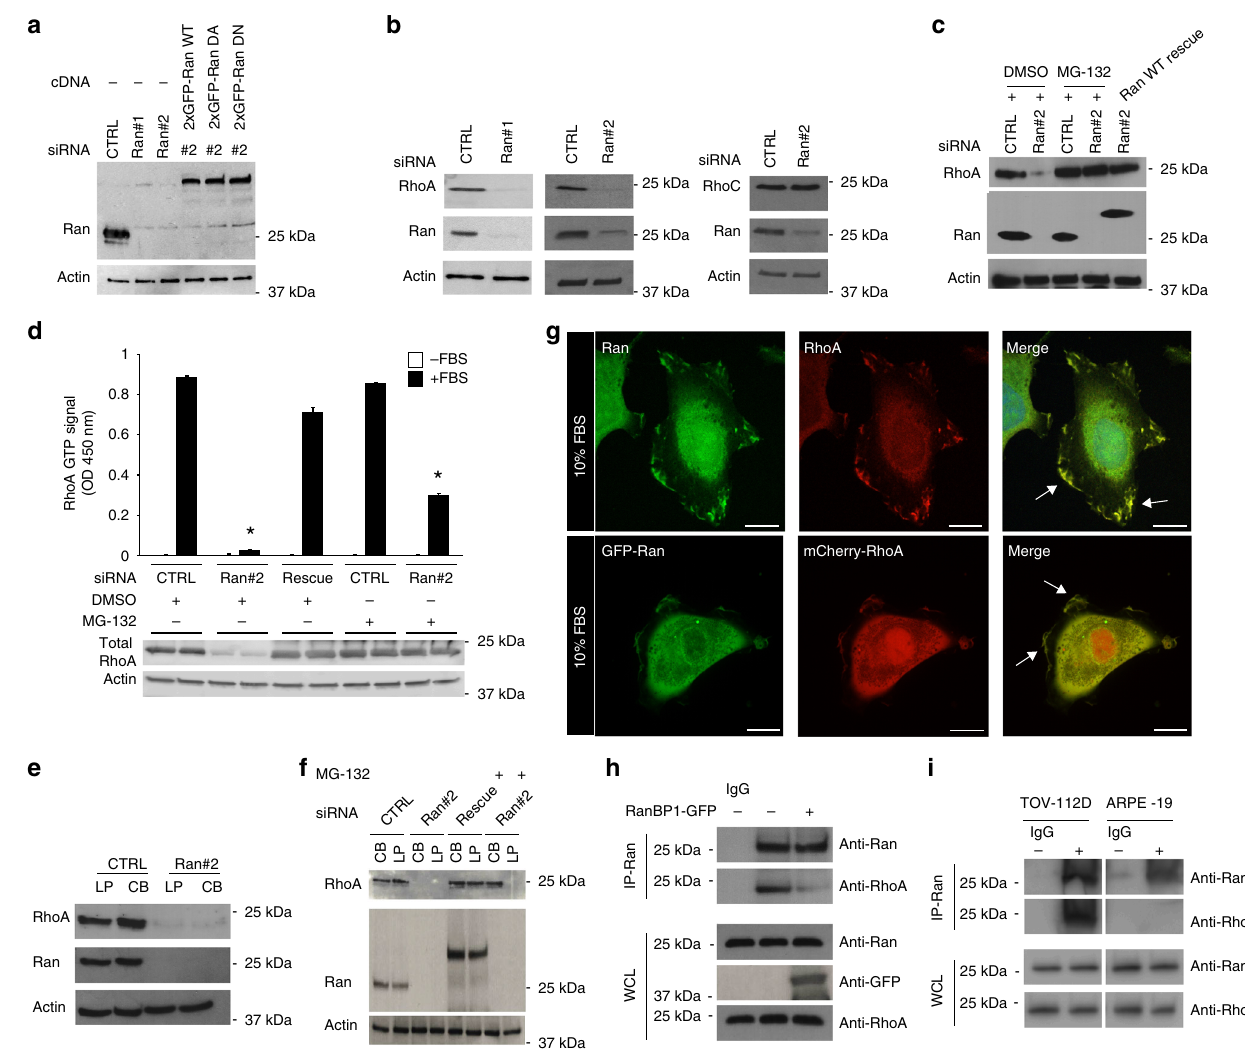
Fig. 1 Ran GTPase stabilizes and co-localizes with RhoA at the plasma membrane of TOV-112D cells. a Western blot of Ran knockdown (KD) with siRNA (CTRL, Ran #1 or 2) and rescue levels with different RNAi-resistant 2xGFP constructs of Ran as wild-type (WT), dominant active (DA), and dominant- negative (DN) in TOV-112D. Actin served as a loading control for all blots. b Western blot showing RhoA and RhoC protein expression levels after Ran KD in cells. c Western blot showing RhoA protein level after re-expression of 2xGFP-Ran WT (Ran WT rescue) or treatment for 2 h with 20 µ M MG-132 in cells transfected with CTRL or Ran #2 siRNA. d Active RhoA was examined in cell lysates of control (CTRL), Ran KD or Ran KD with Ran WT rescued. All values are means± SEM from three independent experiments. P -values are based on comparisons with CTRL using the t test: * P < 0.05 was considered statistically signi fi cant. Western blot showing total RhoA. e , f Cell body (CB) and lamellipodia (LP) of CTRL and Ran KD cells (with or without Ran WT rescued) were fractionated and treated with or without 20 µ M MG-132 for 2 h. Equal amounts of proteins were immunoblotted to show RhoA expression in the respective fractions. RhoA was decreased in CB and LP in Ran KD cells, but unchanged in CTRL. RhoA expression is only rescued in CB fractions after treatment with MG-132. g Top, TOV-112D cells were fi xed, permeabilized, and subjected to immuno fl uorescence using Ran and RhoA antibodies and DAPI (Merge). Bottom, TOV-112D cells transfected with 2xGFP-Ran and mCherry-RhoA were visualized by spinning disk microscopy. Arrows show Ran and RhoA colocalization at the plasma membrane. h TOV-112D cells were transfected with RanBP1-GFP. Protein lysates were subjected to IP with Ran or control IgG antibodies. Proteins were separated by SDS-PAGE and immunoblotted for endogenous RhoA and Ran. i Protein lysates from TOV-112D and ARPE-19 cells were subjected to IP with Ran or control IgG antibodies. Proteins were separated by SDS-PAGE and immunoblotted for endogenous RhoA and Ran. Scale bars, 10 µ